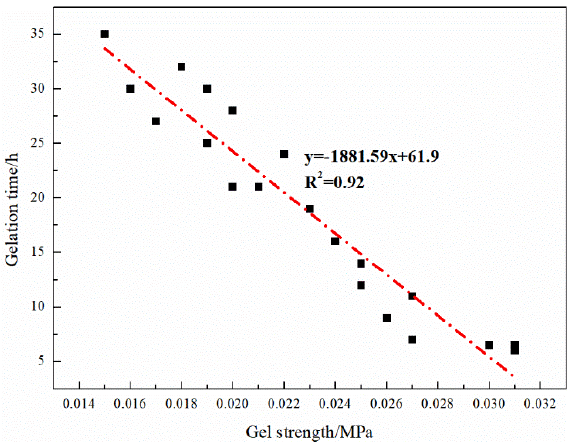
Figure 6. Fitting curves of breakthrough vacuum and gelation time.